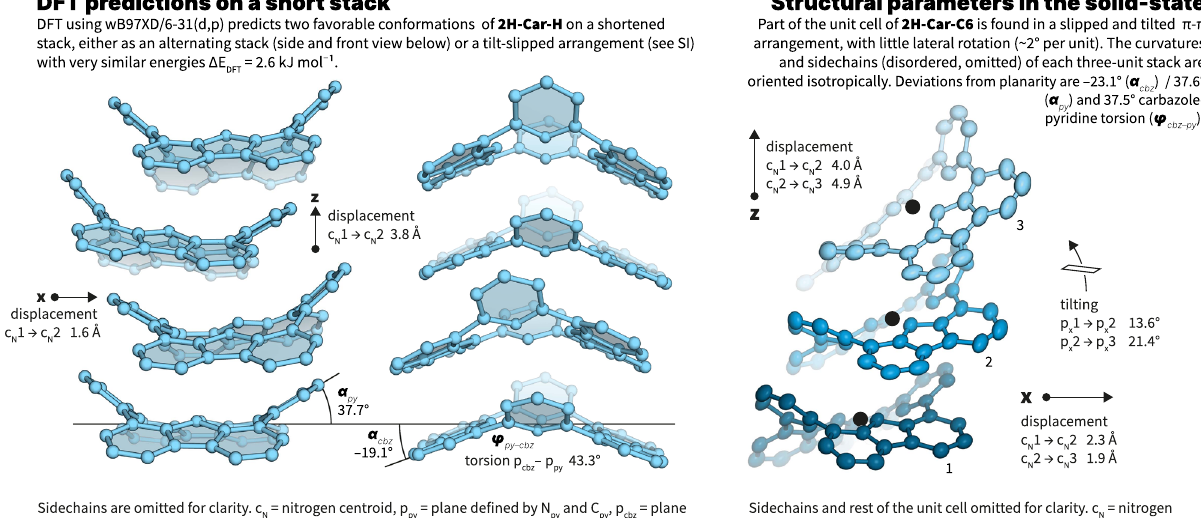
Fig. 4 Structural considerations. Left, DFT calculations of a four-unit stack of the carpyridine core ( 2H-Car-H ) showing the calculated arrangement with retention of the principal axis of curvature. Right, Structural parameters derived from the X-ray single crystal structure of 2H-Car-C6 showing a slipped arrangement also predicted by DFT (see Supplementary